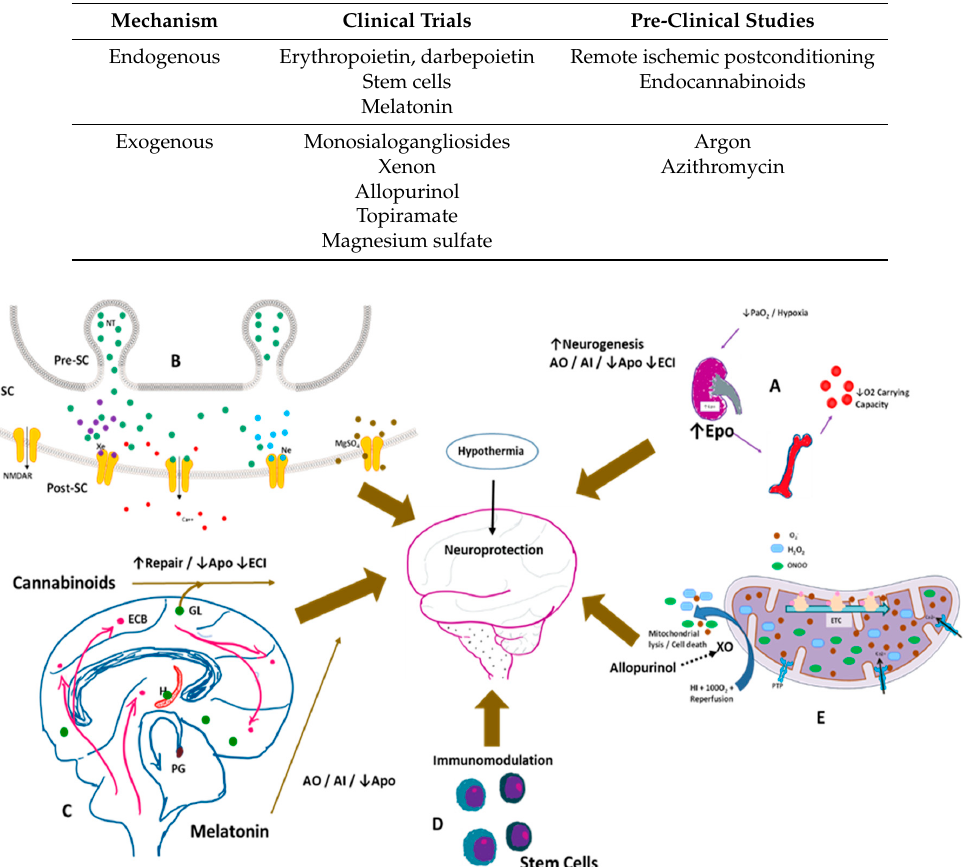
Figure 2. Potential neuroprotective therapies in the management of hypoxic-ischemic encephalopathy. Hypothermia is currently the standard of care in the management of moderate to severe HIE in